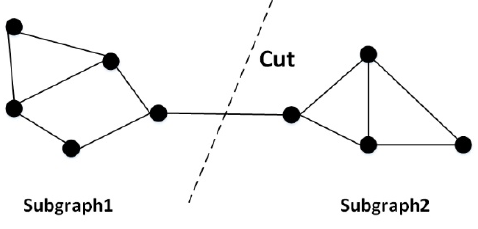
Figure1. Dividing method for spectral